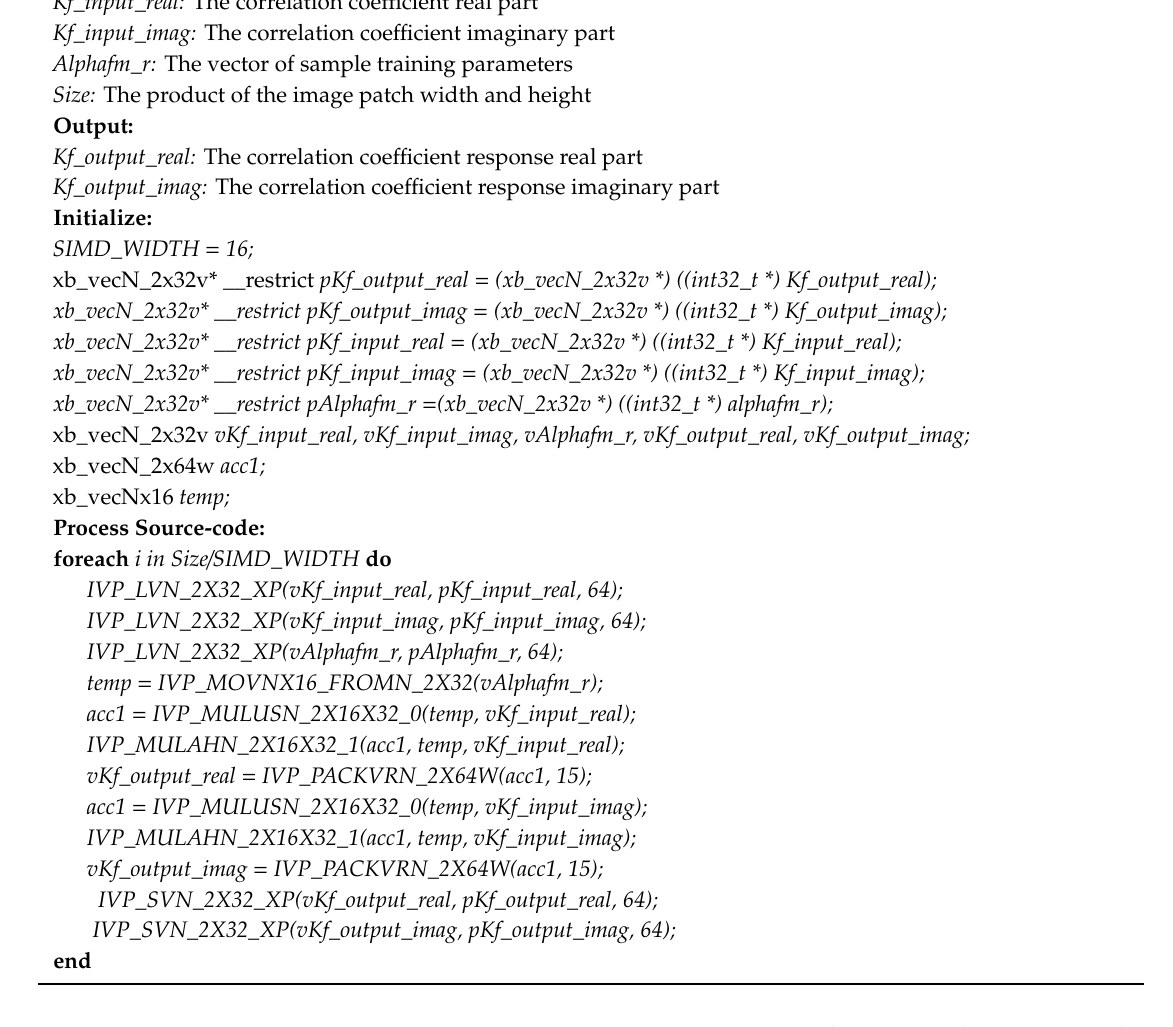
Algorithm 4. Detection process of KCF tracking (calculate the response of the classifier at all shifts), and input and output parameters are vectorized through vector types and keyword